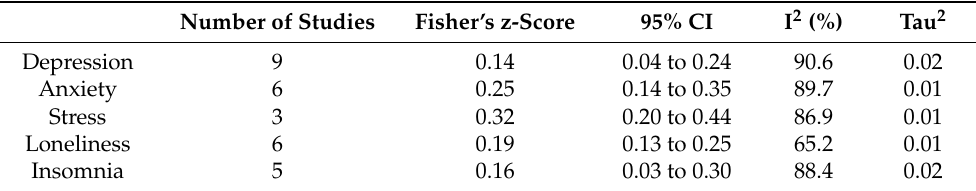
Table 2. The pooled effect sizes for associations between binge-watching and different mental health problems.